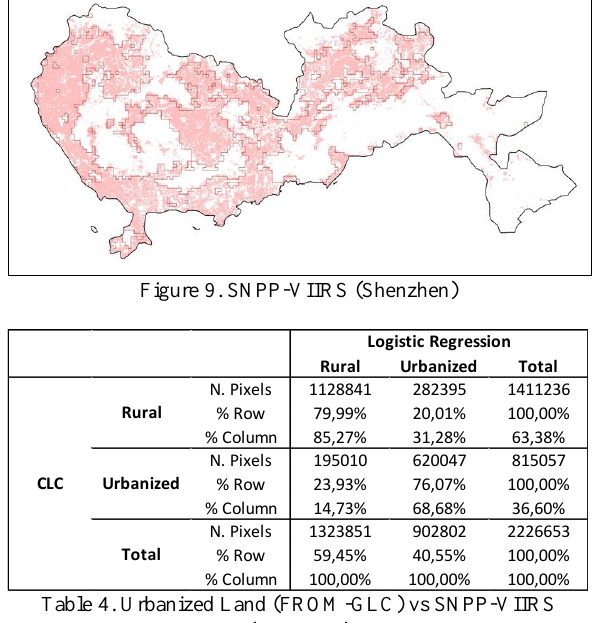
Figure 8. Luojia 1-01 (MRB)